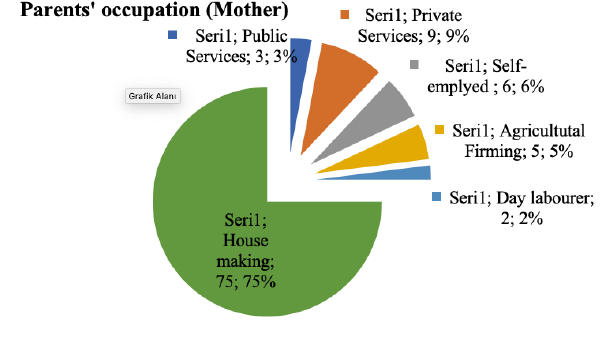
Figure 2: Parent’s Occupation (Mother)